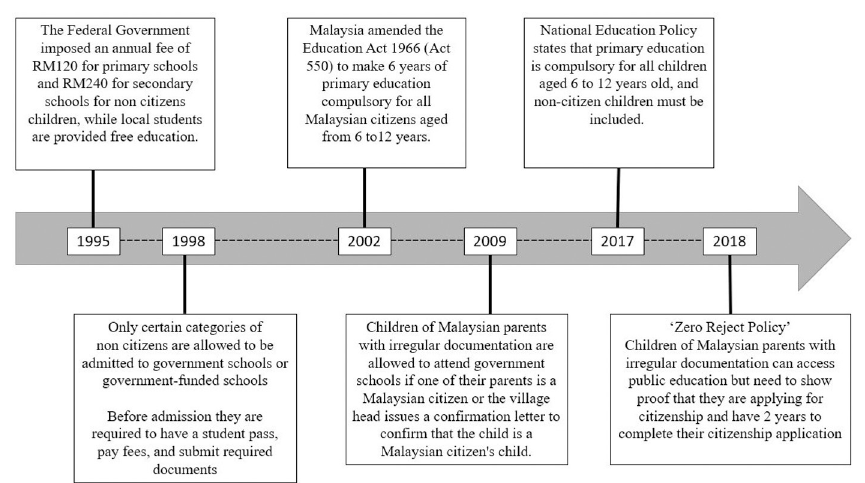
Fig 3. Timeline of the evolution of education policies for non-citizens children in Malaysia. Sourced from